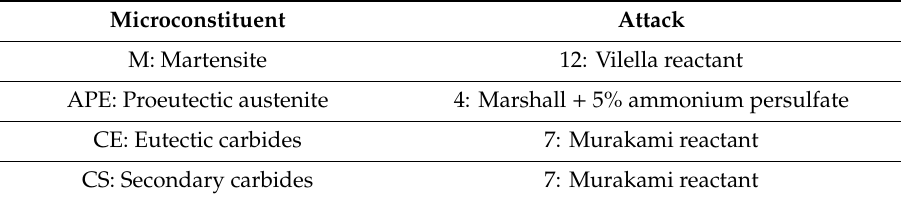
Table 3. Attack selection for each microconstituent present in Ni-hard